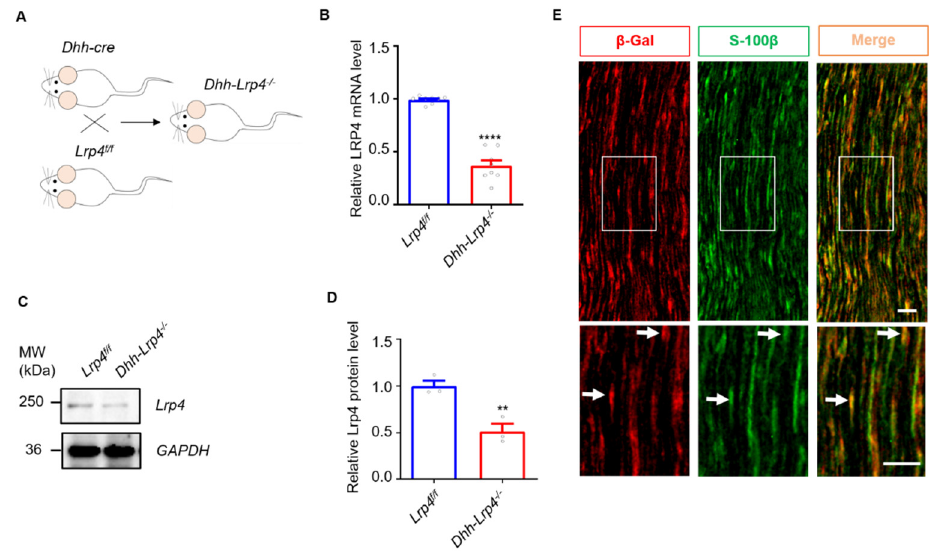
Figure 1. Lrp4 in SCs was successfully deleted in Lrp4 cKO mice. ( A ) Diagram of the strategy used to generate the Lrp4 cKO mice. ( B ) Reduced Lrp4 mRNA levels in cKO mice compared with control mice. **** p < 0.0001, control and cKO, 8 mice/group. ( C , D ) Reduced Lrp4 protein levels in cKO mice compared with control mice. ** p = 0.0083, 3 mice/group. ( E ) The images show that Lrp4 (red) is localized in SCs (green). The white arrows indicate the costaining of β -Gal and S-100 β . Scale bar = 50 μ m.